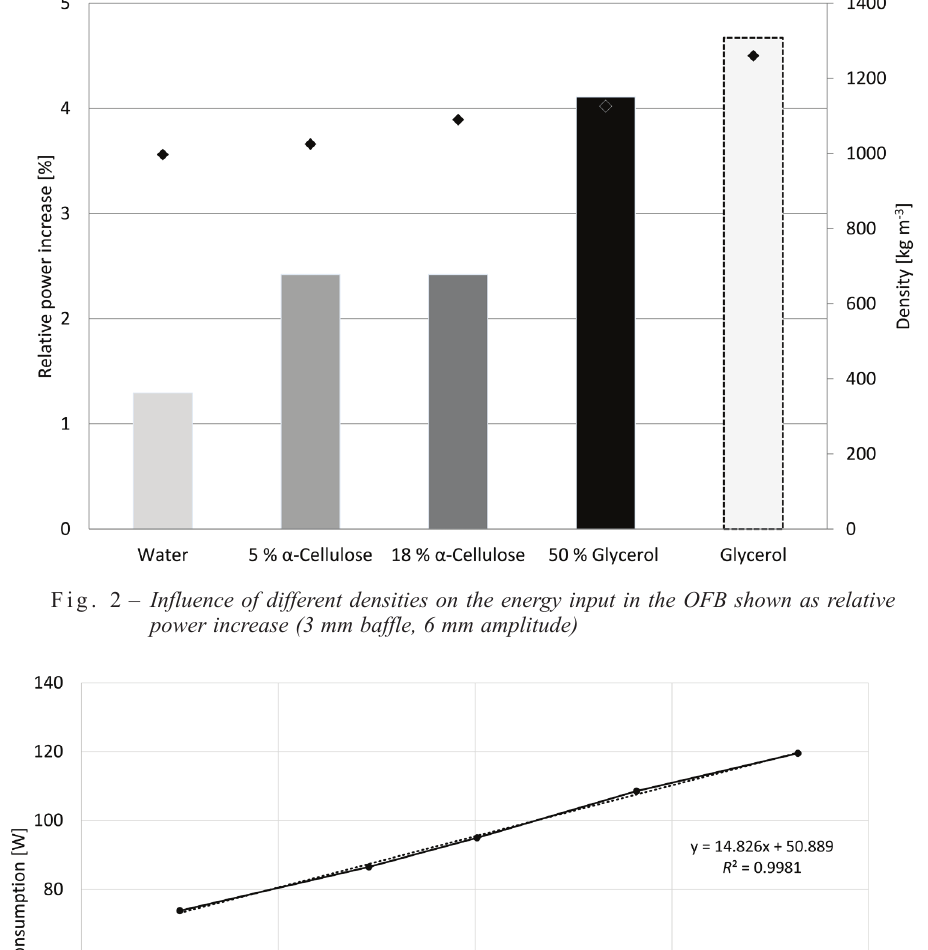
Fig. 3 – Oscillatory power consumption as a function of different frequencies (12 % SL, α-cellulose, 3 mm baffle, 10 mm